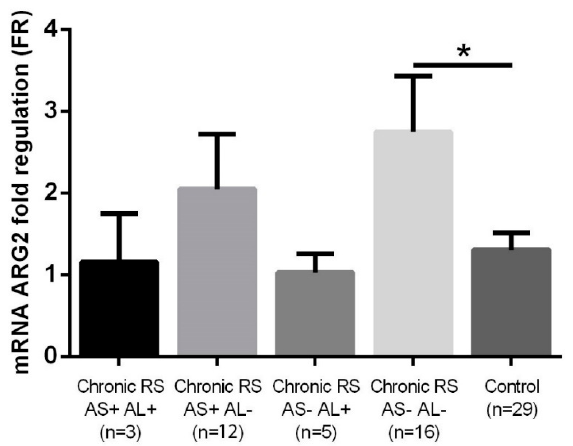
Figure 6. ARG2 expression in the group with chronic rhinosinusitis (with or without asthma/allergy) and in the control group. * p < 0.005, AS+ asthmatic, AS − non-asthmatic, AL+ allergic, AL − non- allergic.